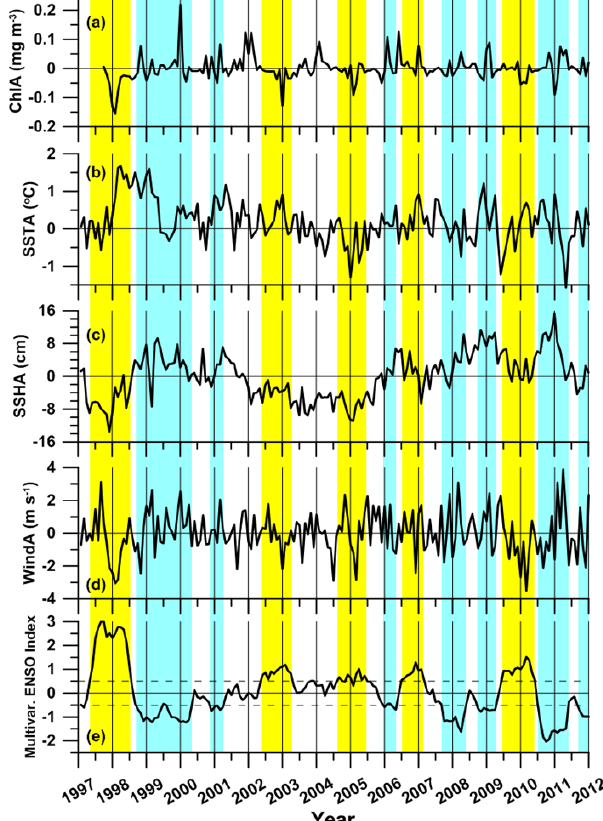
Fig. 9. Variations of monthly mean values of environmental vari- ables within the study area: (a) sea surface chlorophyll- a concen- tration from the merged time-series shown in Fig. 5; (b) sea sur- face temperature; (c) sea surface height; and (d) wind speed at 10m above sea